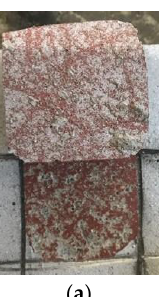
Figure 5. Procedure of image analysis using ImageJ. ( a ) Original image; ( b ) Area detection for im- age analysis; ( c ) Color thresholding. analysis; ( c ) Color thresholding.